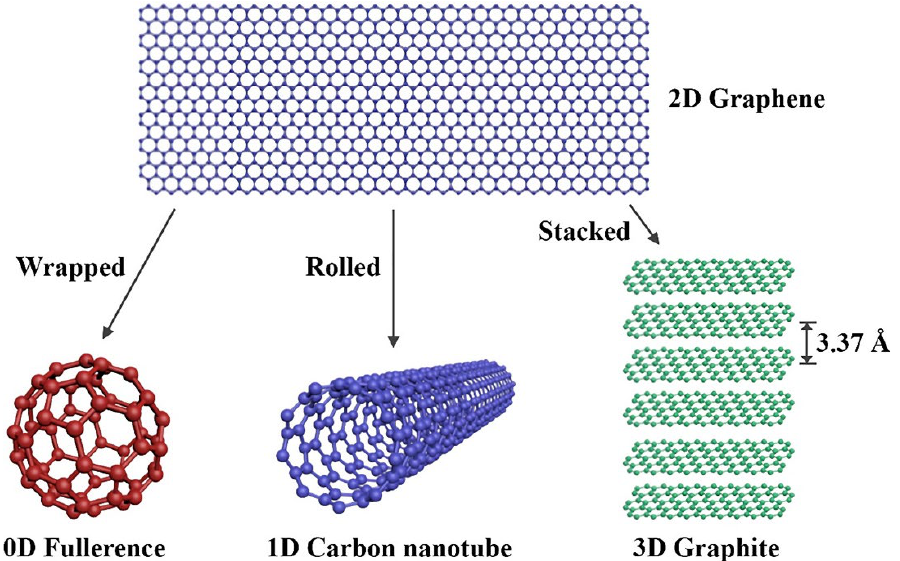
Figure 8. Structures of graphene and its graphitic carbon allotropes. Reproduced with permission from [201].